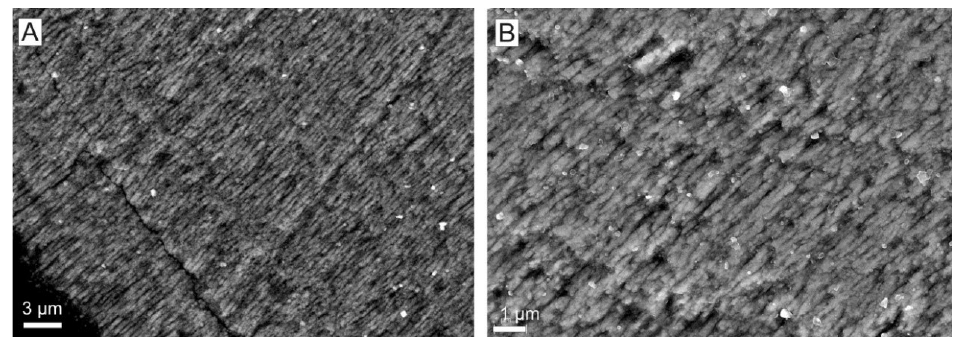
Figure 14. (A-B) SEM images of a transversal thin section of a prong of S. officinalis (SP-10) showing micro-fibrous texture of the crystals, which are distributed in concentric laminae.